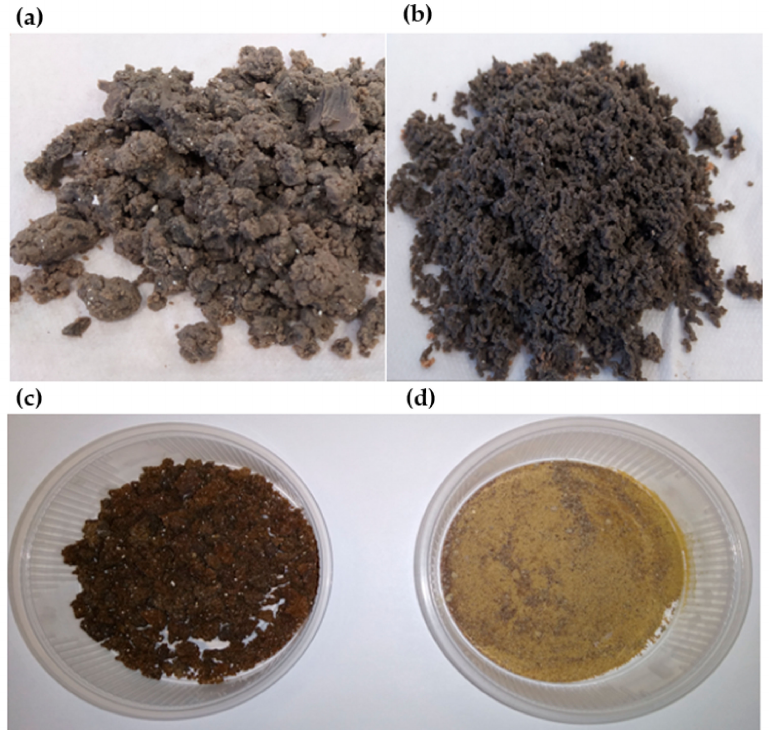
Figure 2. View of the post-flotation dairy sludge ( a ) unmilled, before drying, ( b ) milled, before drying, ( c ) after drying, and ( d ) after drying and